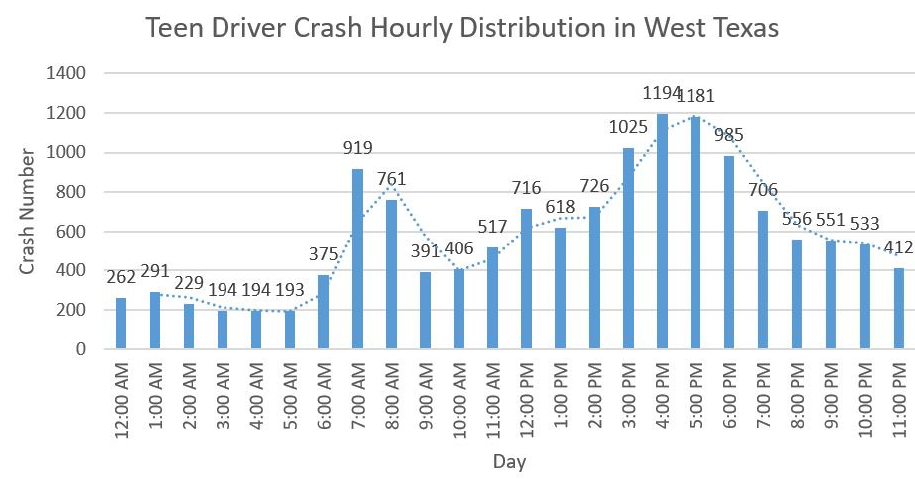
Figure 3. Yearly trend of teen driver crashes in the West Texas rural area.